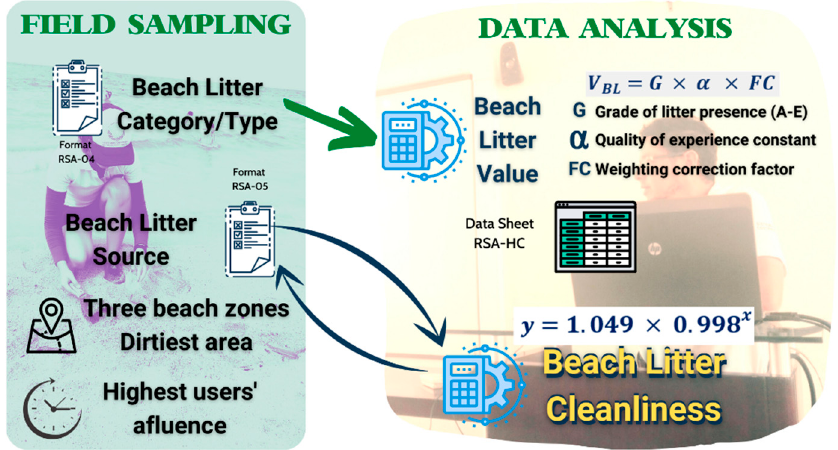
Figure 2. Procedure followed to obtain beach litter grades (qualitative module) and Equations (1) and (2) (quantitative module). Table 2. Qualitative interpretation of beach litter values.